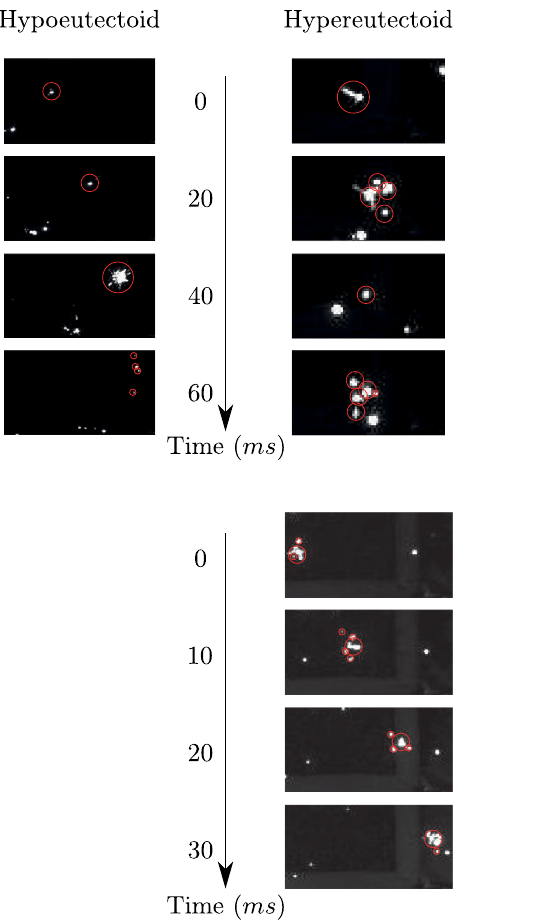
Fig. 3. Different morphologies of splitting: left, explosion of an hypoeutectoid spark; top right, double explosion of an hyper- eutectoid spark; bottom right, constant emission of tiny sparks around an hypereutectoid spark. The sparks circled in red are the products of a single spark.